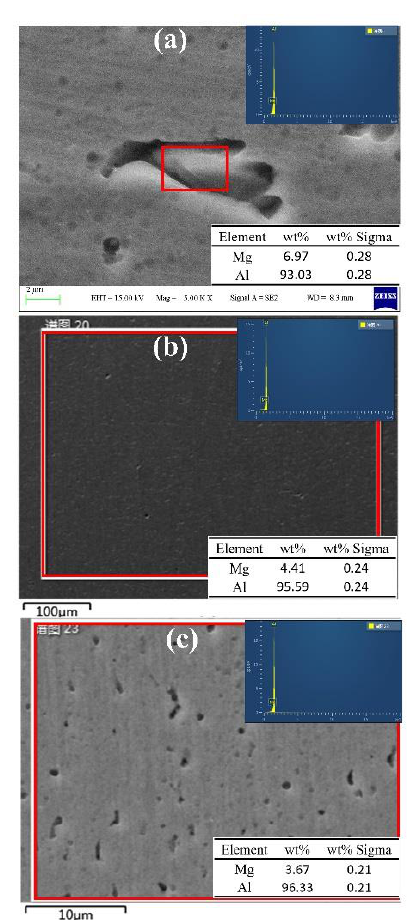
Figure 14. Energy Dispersive Spectrometer (EDS) results of the microstructure characteristics observed via a scanning electron microscope (SEM): ( a ) skeletal structure; ( b ) feeding wire; ( c ) specimen by NC process.